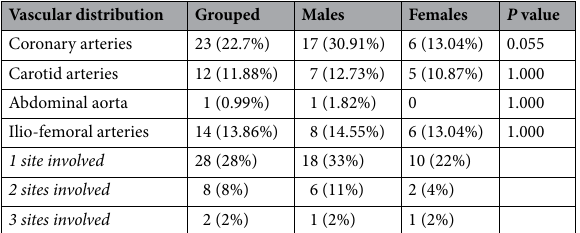
Vascular distribution